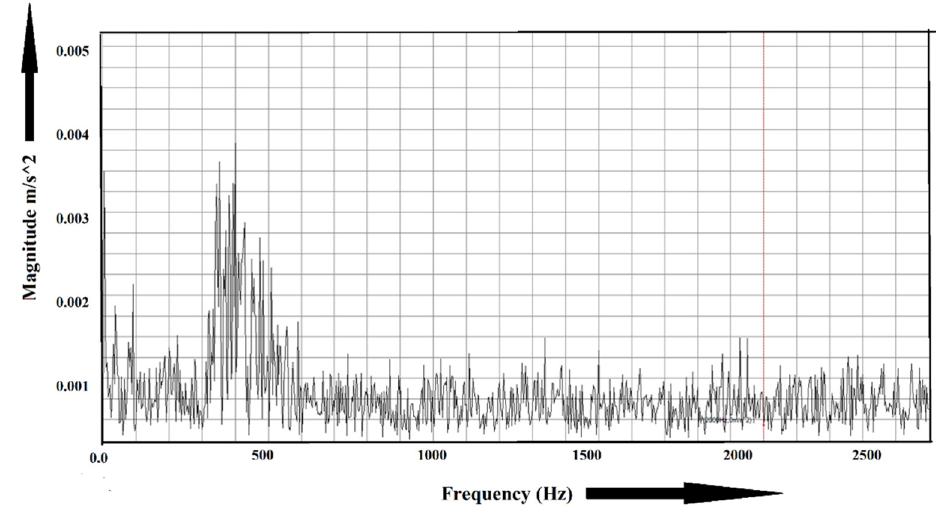
Figure 6. Frequency spectrum of a healthy bearing.